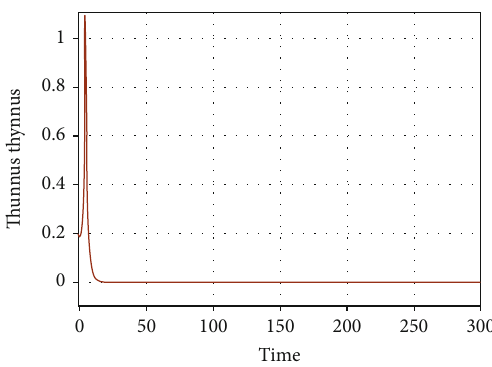
Figure 5: Dynamical behavior of the susceptible Thunnus thynnus.